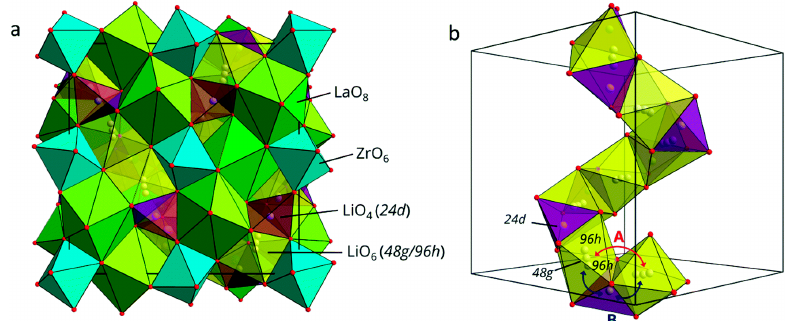
pathways (a segment of this network is illustrated in Figure 22b).